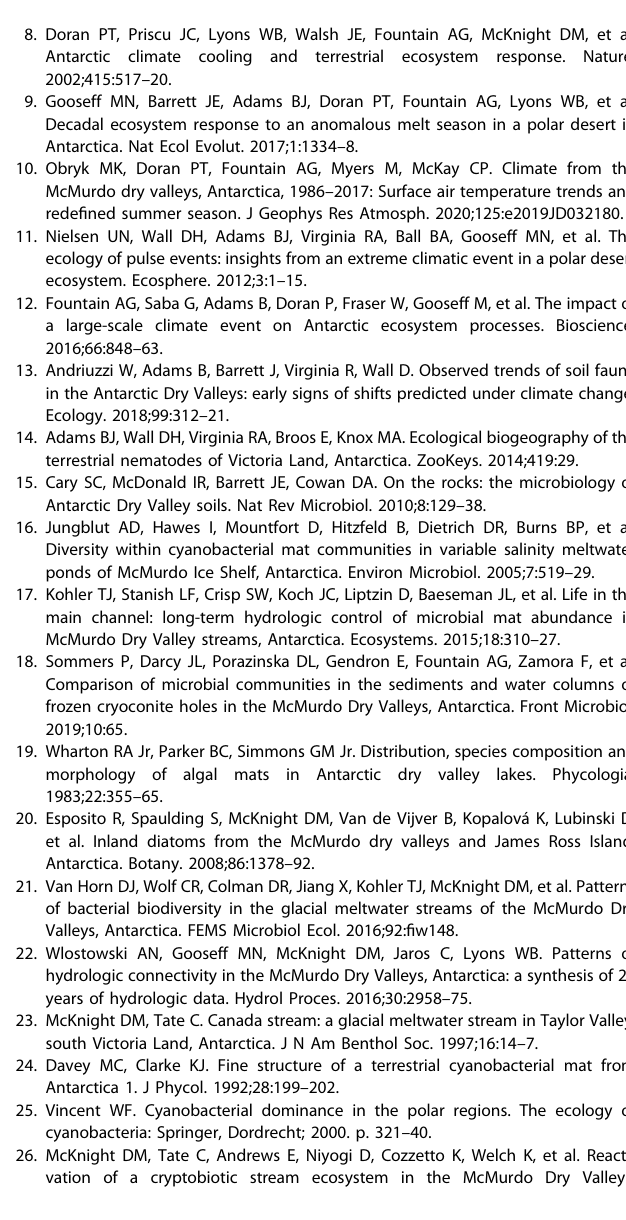
Fig. 7 Microbial Mat Antifreeze Activities. Thermal hysteresis antifreeze activities of black, red, green and orange mats with no annealing period (left) and after a thirty minute annealing period